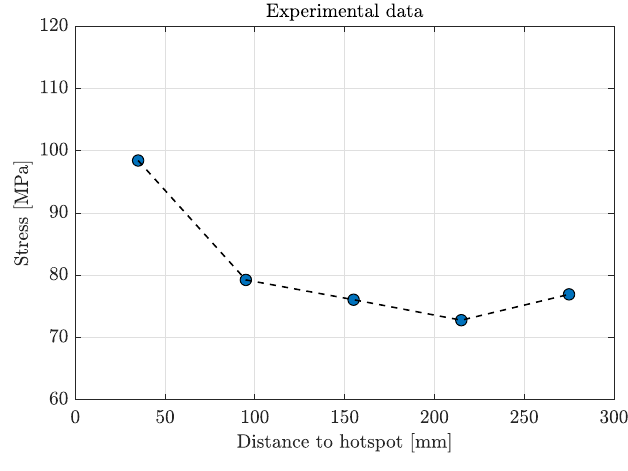
Figure 4. Test data.